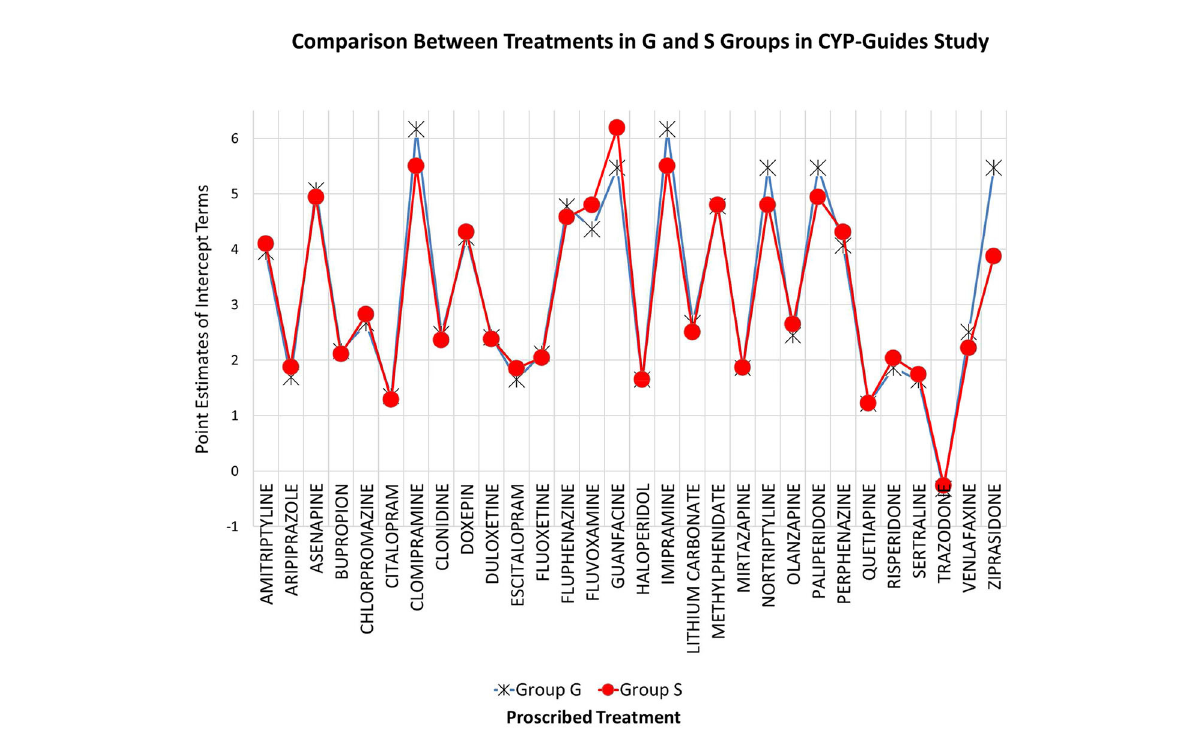
FIGURE1 Known groups latent class model for evaluating the equivalence of treatment medications across G and S groups in CYP-guides study. Estimates reflect levels in the administration of drugs across treatment